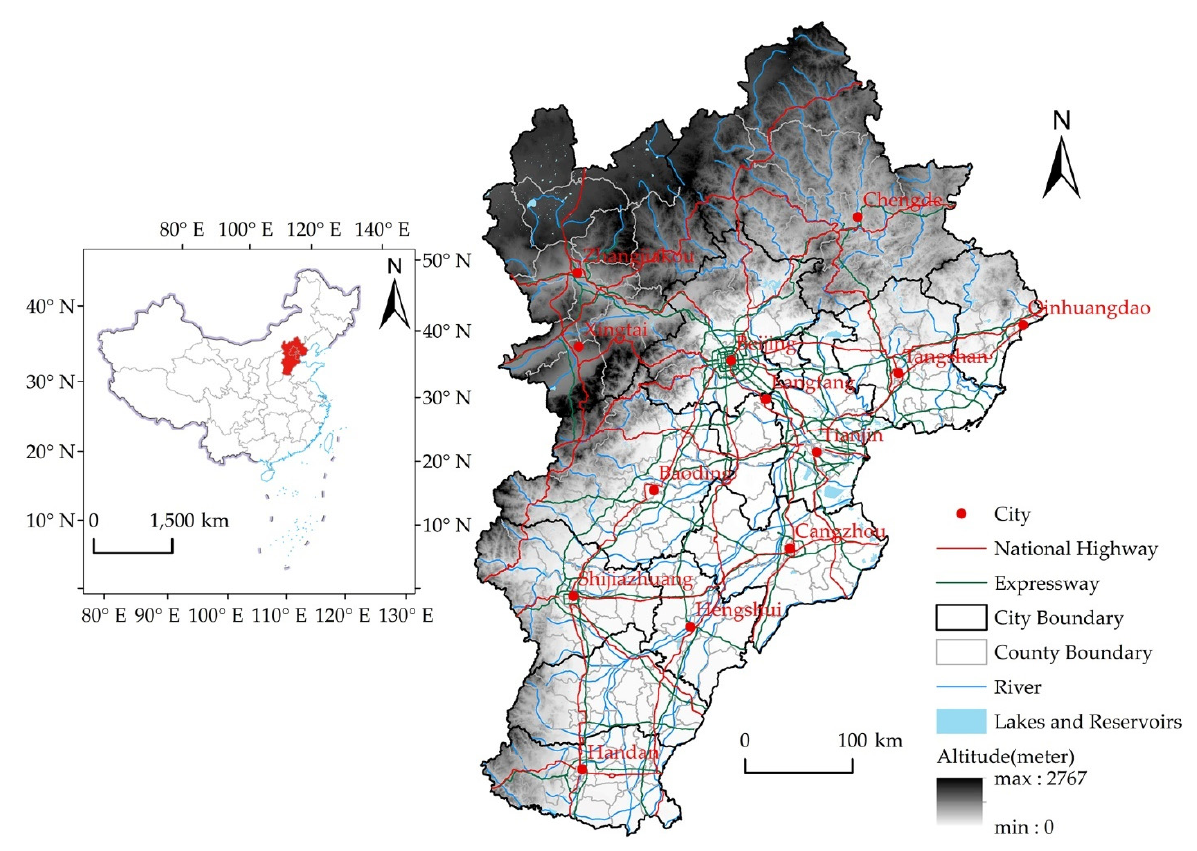
Figure 1. Research Figure 1. Research area.